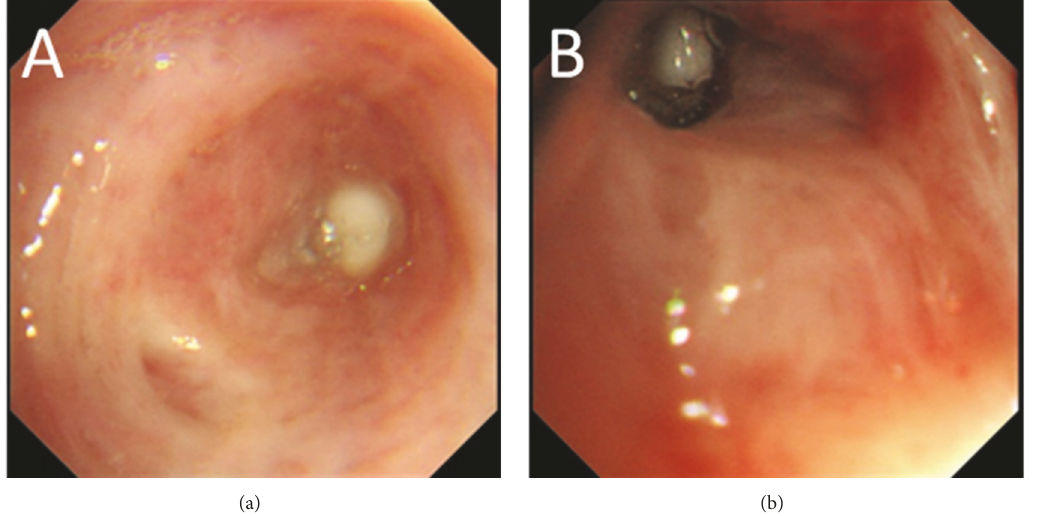
Figure 3: (a) Endoscopy showed a bronchial occlusion in the right B 2 at the first session using an endobronchial Watanabe spigot. (b) Endoscopy showed a bronchial occlusion in the right B 1 b at the second session using an endobronchial Watanabe spigot.